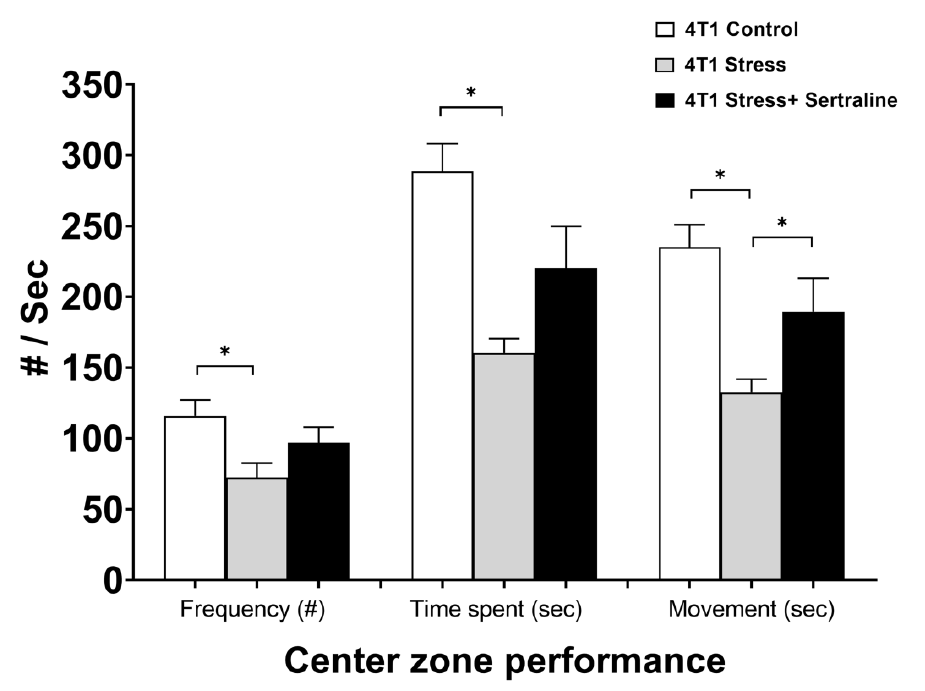
Figure 3. Behavior of 4T1cell inoculated mice in Open Field test—Effects of chronic mild stress (CMS) and sertraline treatment (5 mg/kg/d, seven days after 4T1 cell inoculation) on center zone performance in Open Field test were measured by frequency of entry into center zone, time spent in it and duration of movement in the center. Results are expressed as mean ± SE of three separate experiments, which included five mice per group. * p < 0.05.